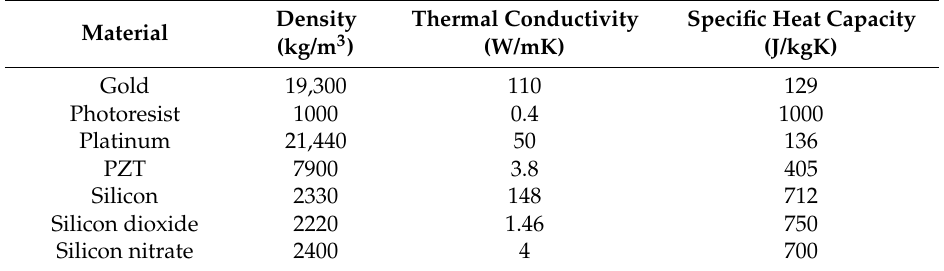
Table 1. The properties of materials used in the thermal simulation of the sensor.